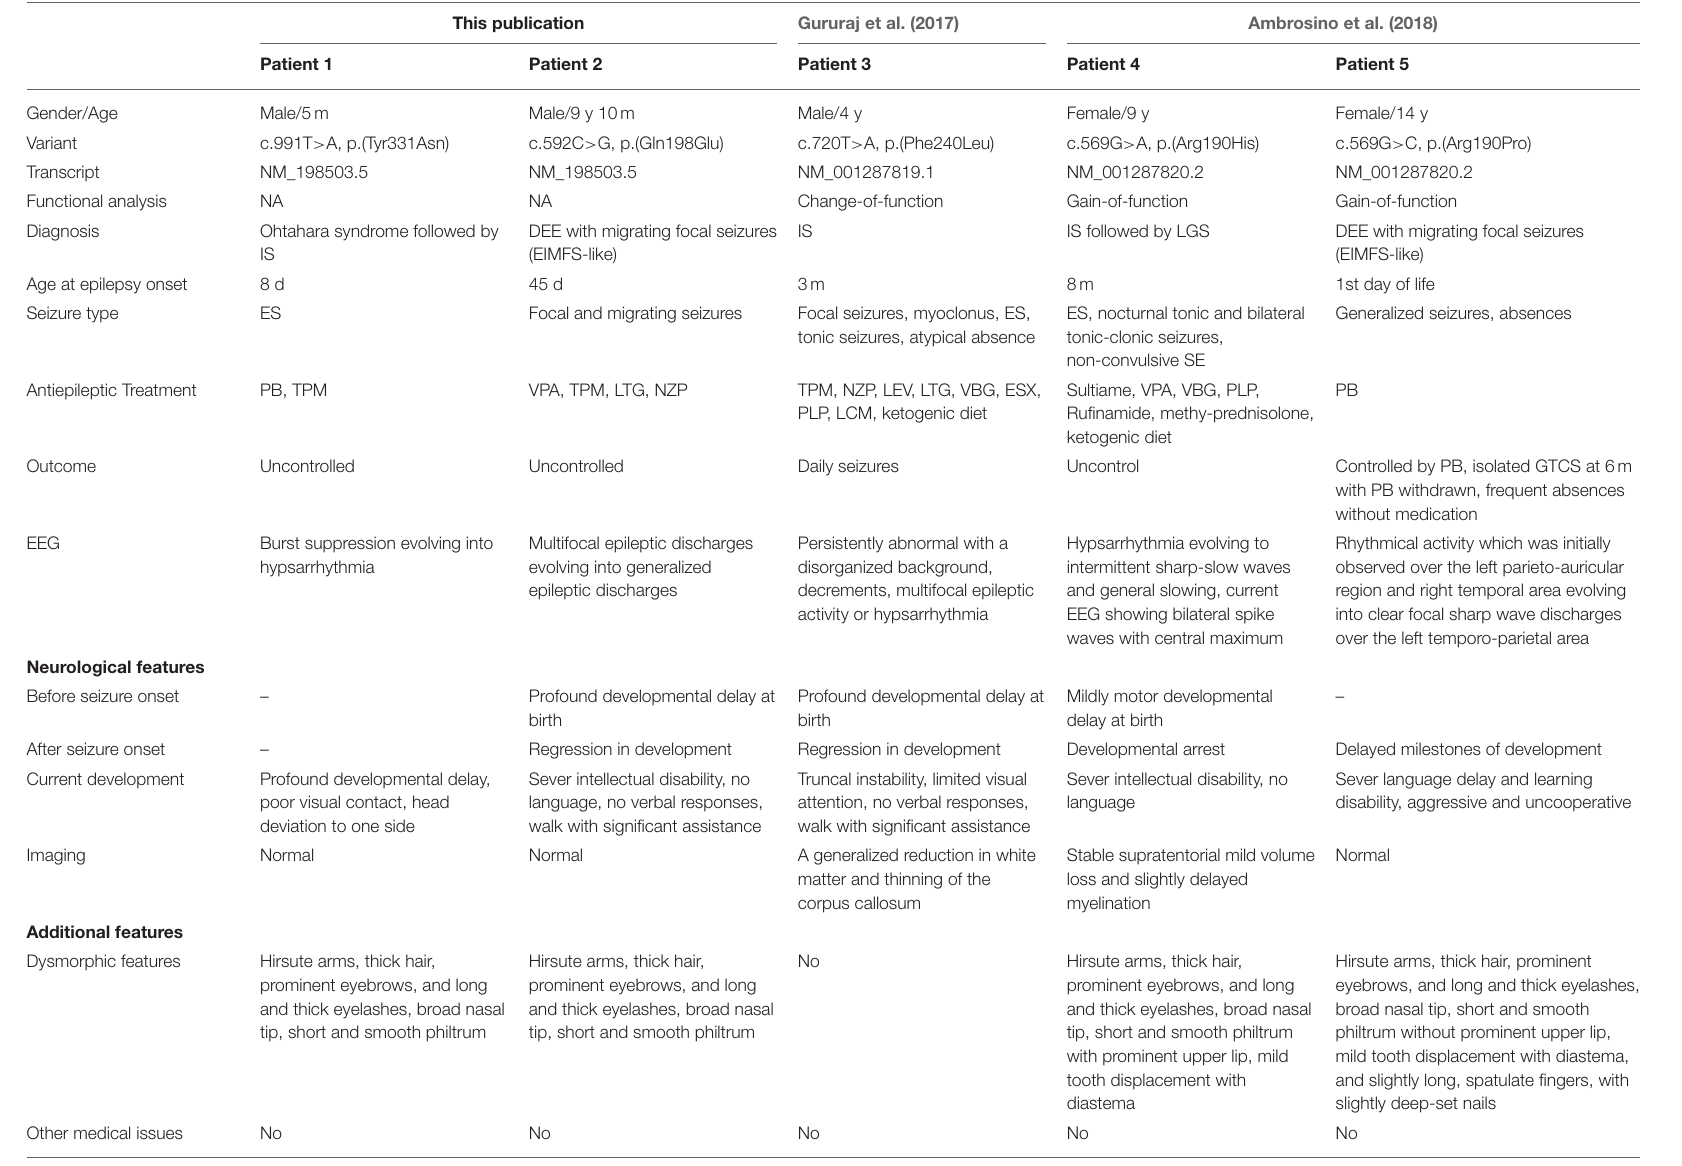
TABLE 1 | Patients with KCNT2 variants in this publication and previous